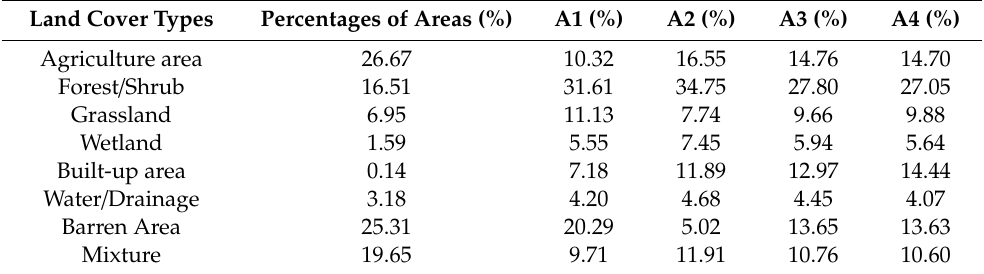
Table 5. Area percentages of the land cover types and A1–A4 soil retention